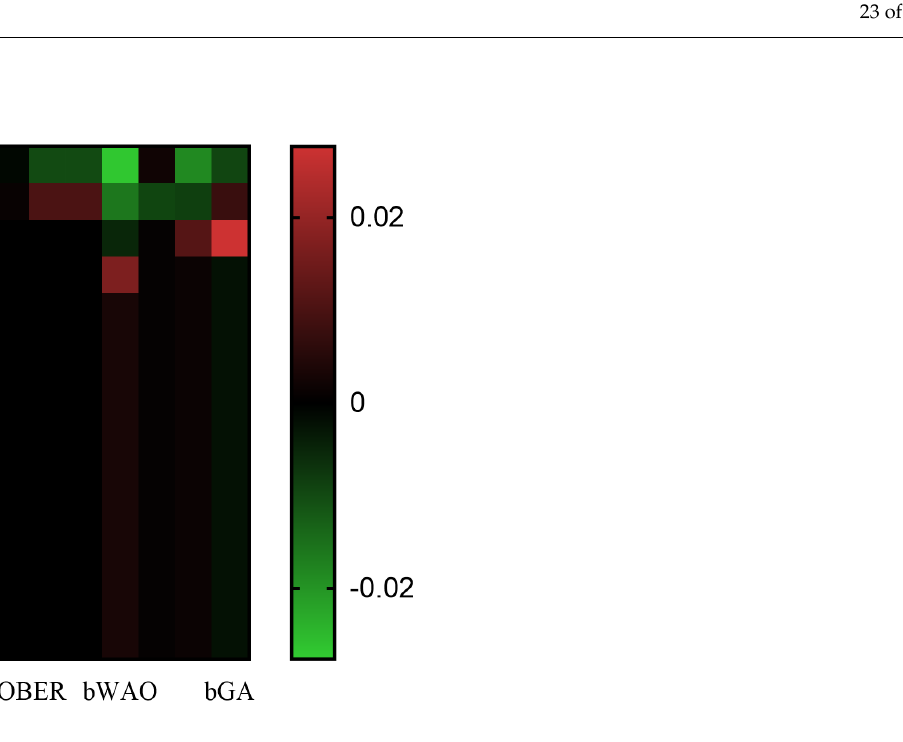
Figure 12. Heatmap of the achieved results based on the proposed feature selection algorithm, bPSOBER.